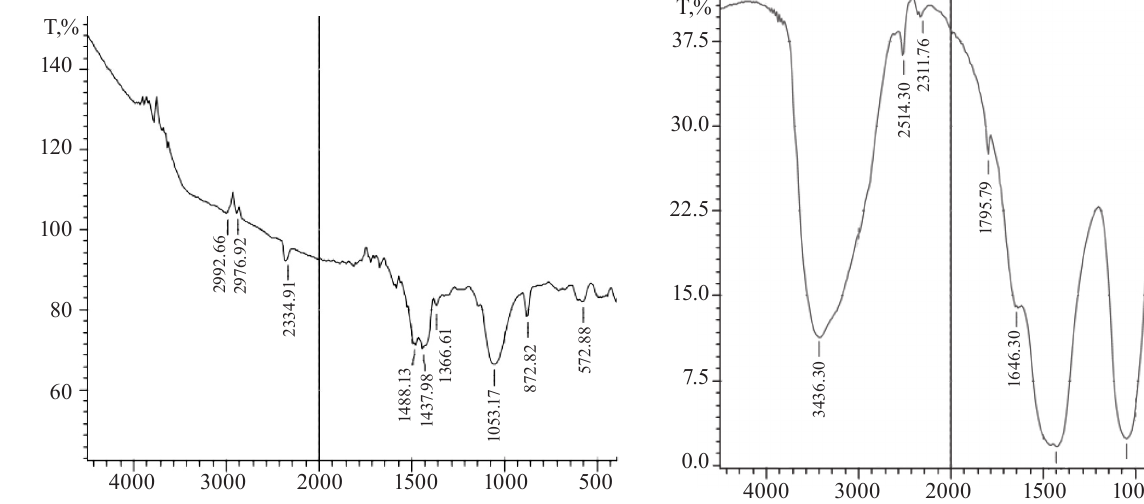
Figure 9 Infrared spectra of activated charcoal after adsorption of methylene blue